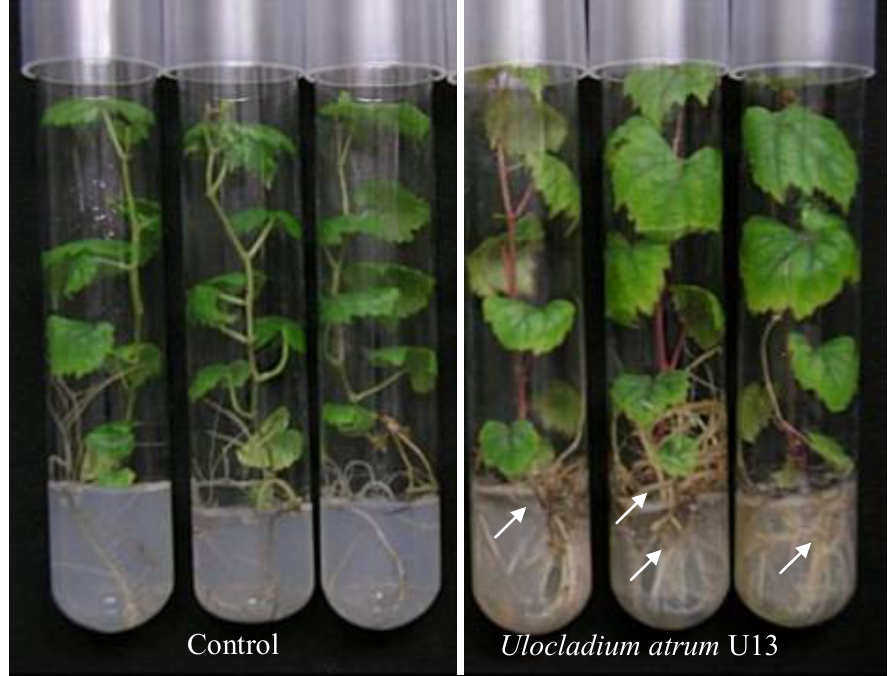
Figure 6. In vitro responses of grapevine plantlets co-cultured with U. atrum isolate U13. The presence of antagonist induces a strong development of roots